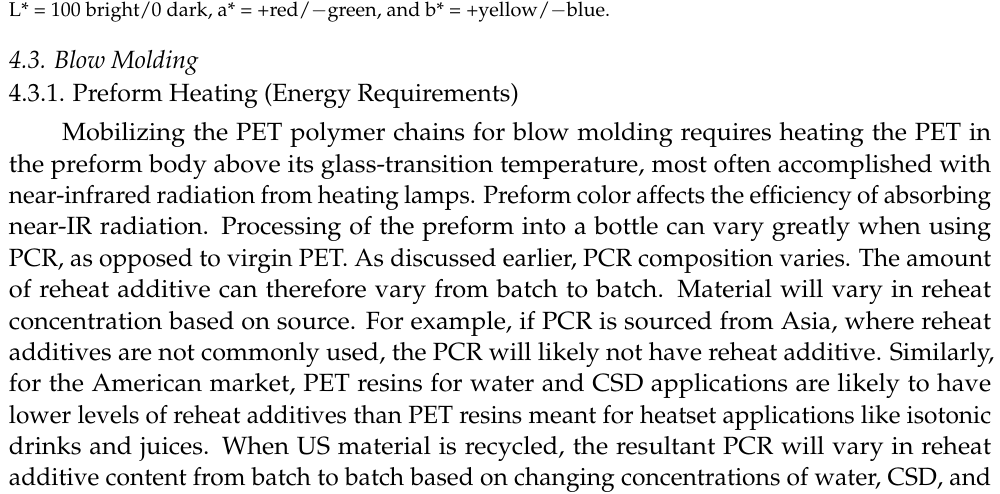
Figure 15. PCR preforms and bottles (image courtesy of Amcor).